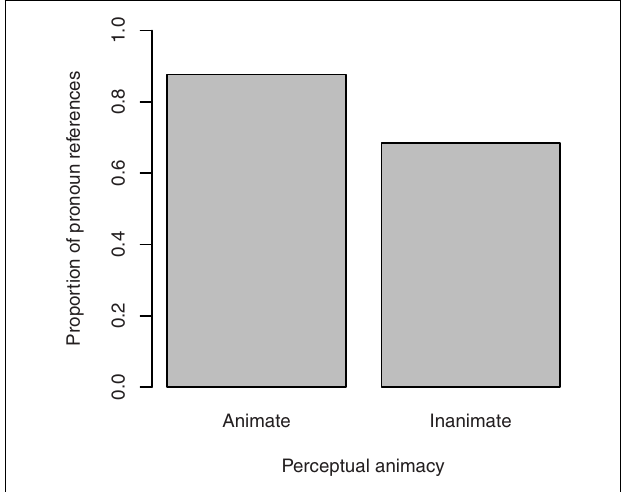
FIGURE 8 | Proportion of pronoun references to the target figure in the description of the transitive action in Experiment 2, by its perceptual animacy